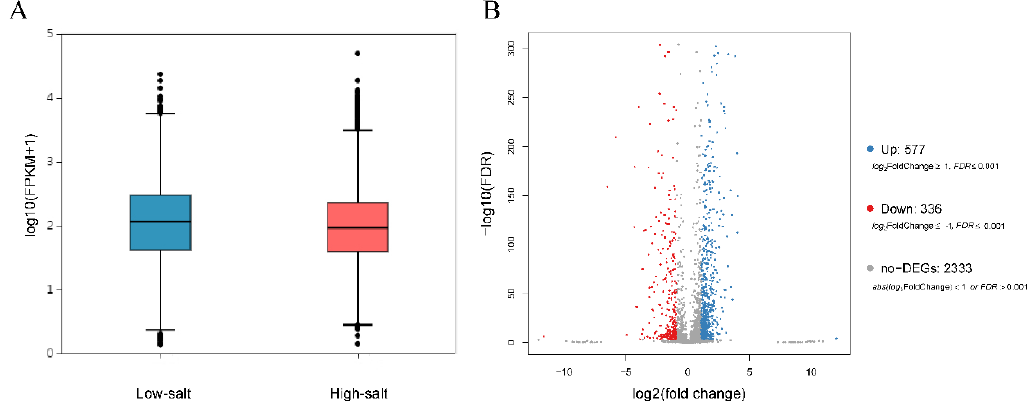
Figure 5. Gene expression analysis. ( A ) Box plot of the total expressed genes evaluated by FPKM method in the low-salt or high-salt condition. ( B ) Volcano plot of the genes differentially expressed between the two samples. The blue and red colors represent upregulated and downregulated genes, respectively.